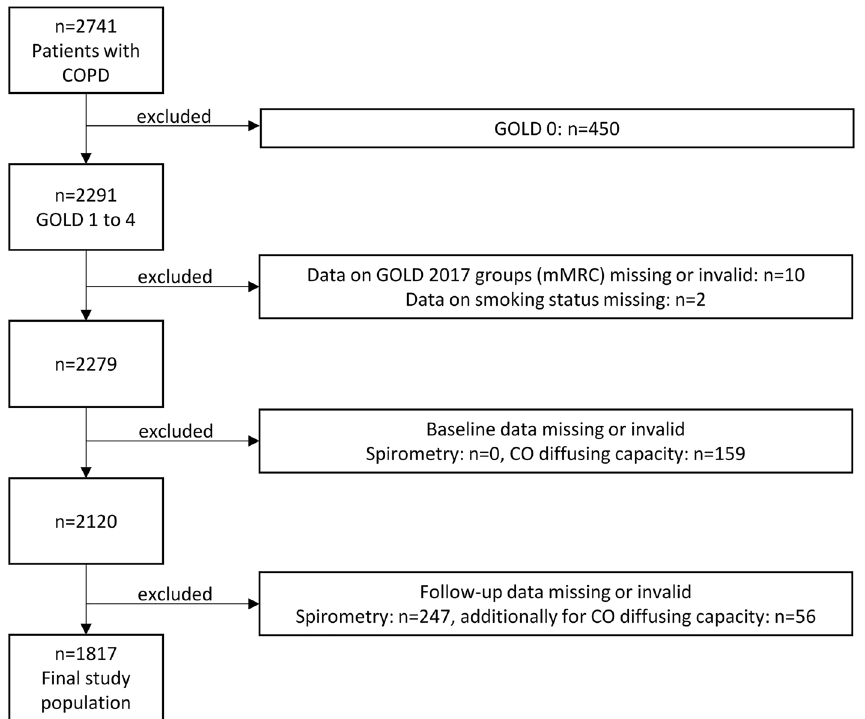
Figure 1. Study flow chart showing the selection process of patients. GOLD, Global Initiative for Chronic Obstructive Lung